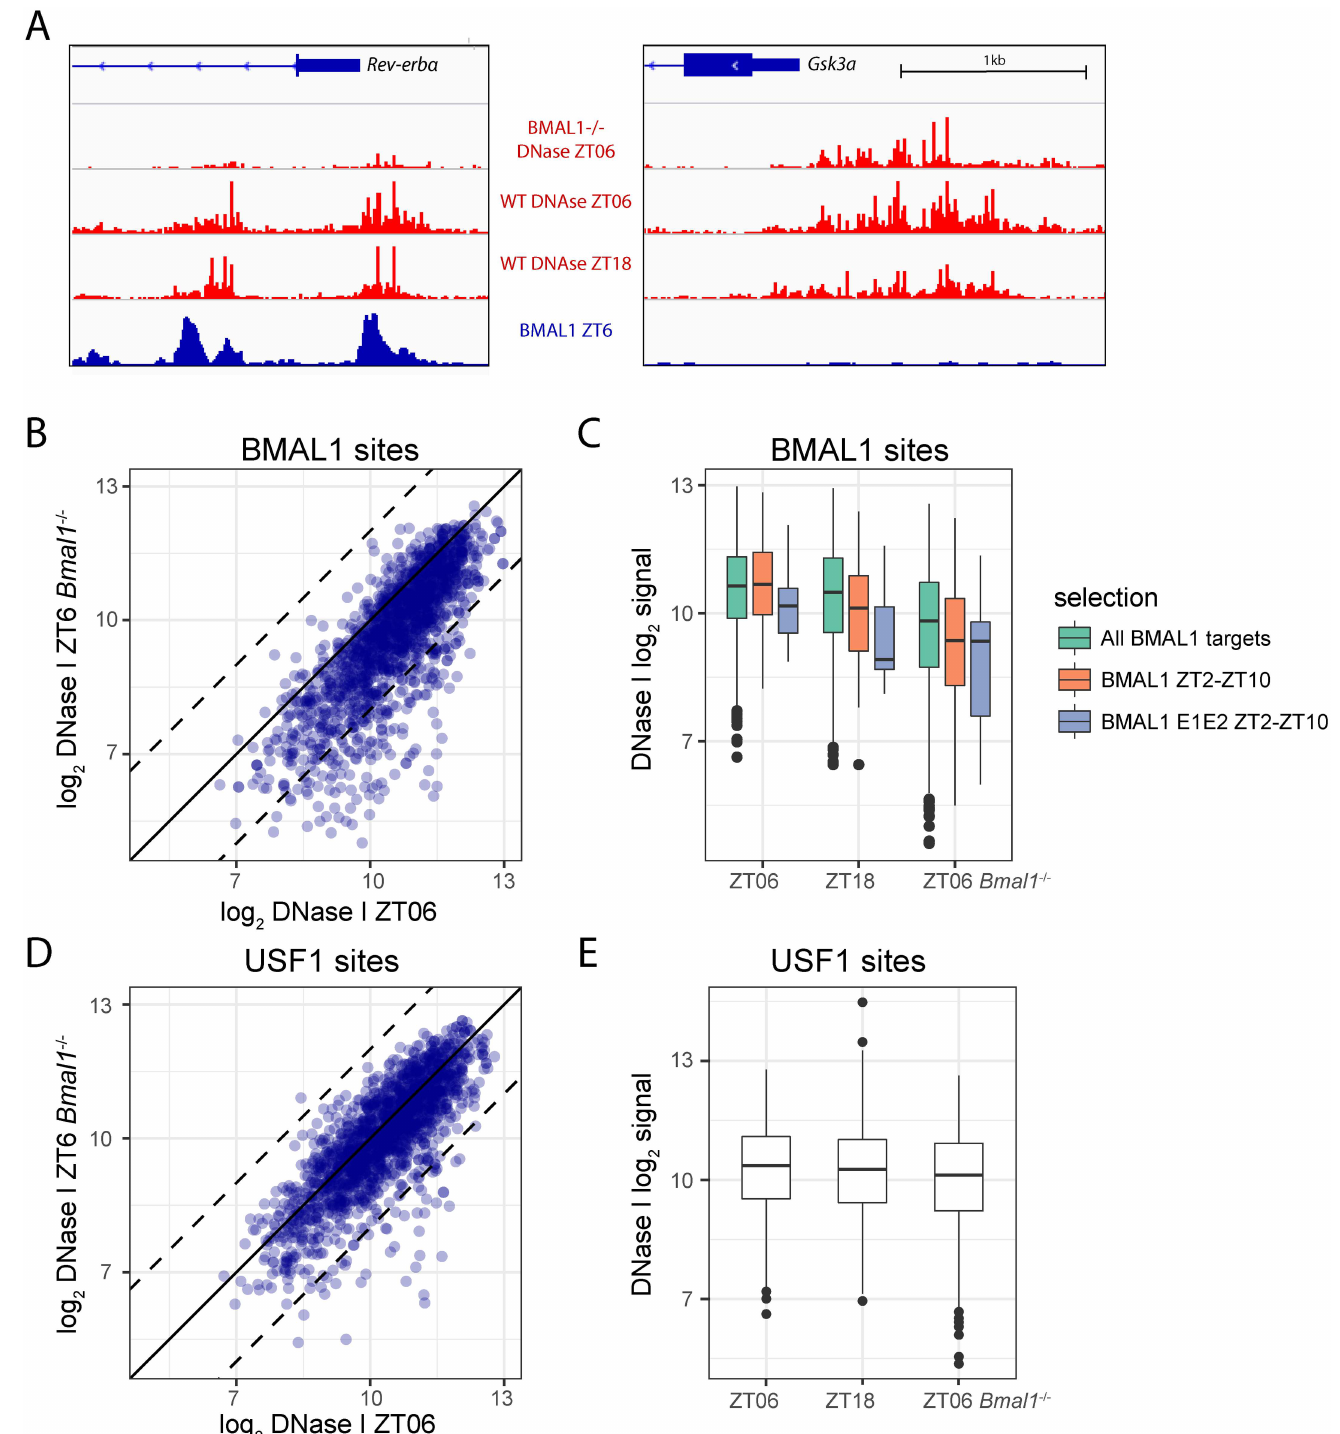
Fig 5. Chromatin accessibility in Bmal1 -/- mice at ZT6 is generally similar as in the Wild-Type (WT) mice but is lower at BMAL1 sites. A. The Rev-erb α (left) and Gsk3a (right) promoters. DNase I signal (in red) is strongly reducedin Bmal1 -/- mice at sites bound by CLOCK:BMAL1 in WT mice (BMAL1 chromatinimmunoprecipitationfollowedby DNA sequencing(ChIP-seq) signal in blue) in the Rev-erb α promoter but is similar in WT and Bmal1 -/- mice at the Gsk3a promoter that are not boundby BMAL1. The vertical scale is the same for all three DNase I tracks, as well as for both BMAL1 ChiP-seq tracks. Wild-type ZT18 signalsare lower (about half) than at ZT6 in both genes but not as low as in the Bmal1 -/- mice. B. Comparisonof